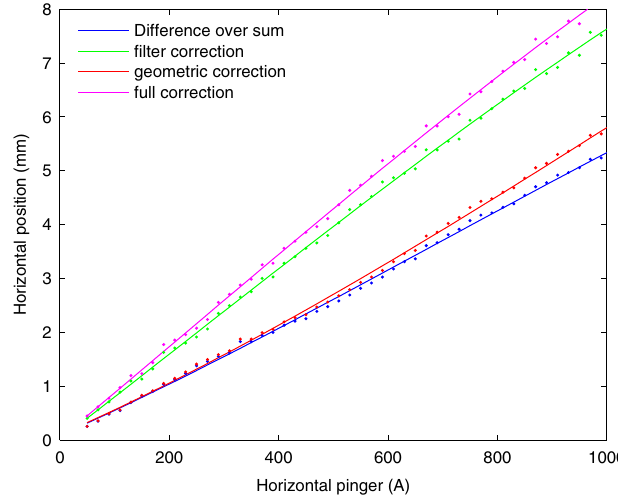
FIG. 8. Horizontal beam position as a function of pinger magnet strength, illustrating the relevance of correctly treating the individual button signals when reconstructing the measured position: blue are the raw BPM data given by the difference over sum formula; red data have the correction of the geometric nonlinearity only; green data have the deconvolution of the time filter only; magenta are the data with the full reconstruction. The solid lines are third order fit to the